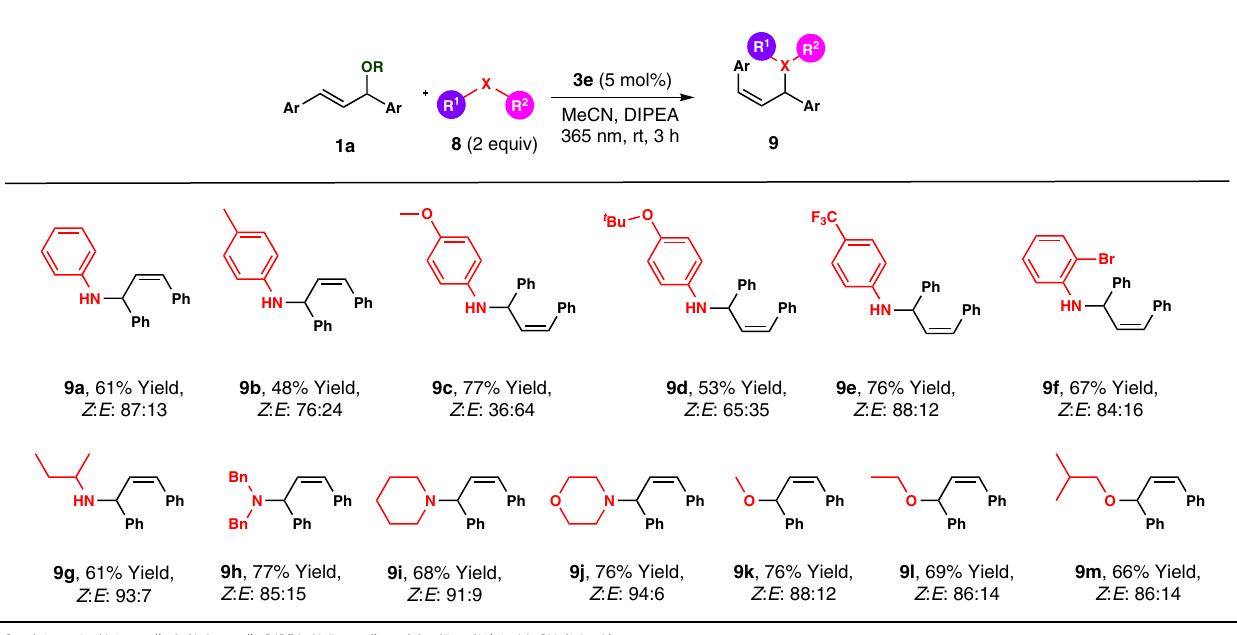
Table 4 Scope of the allylation reaction with amines and alcohols for the synthesis of Z -isomers under photocatalyst 3e a,b